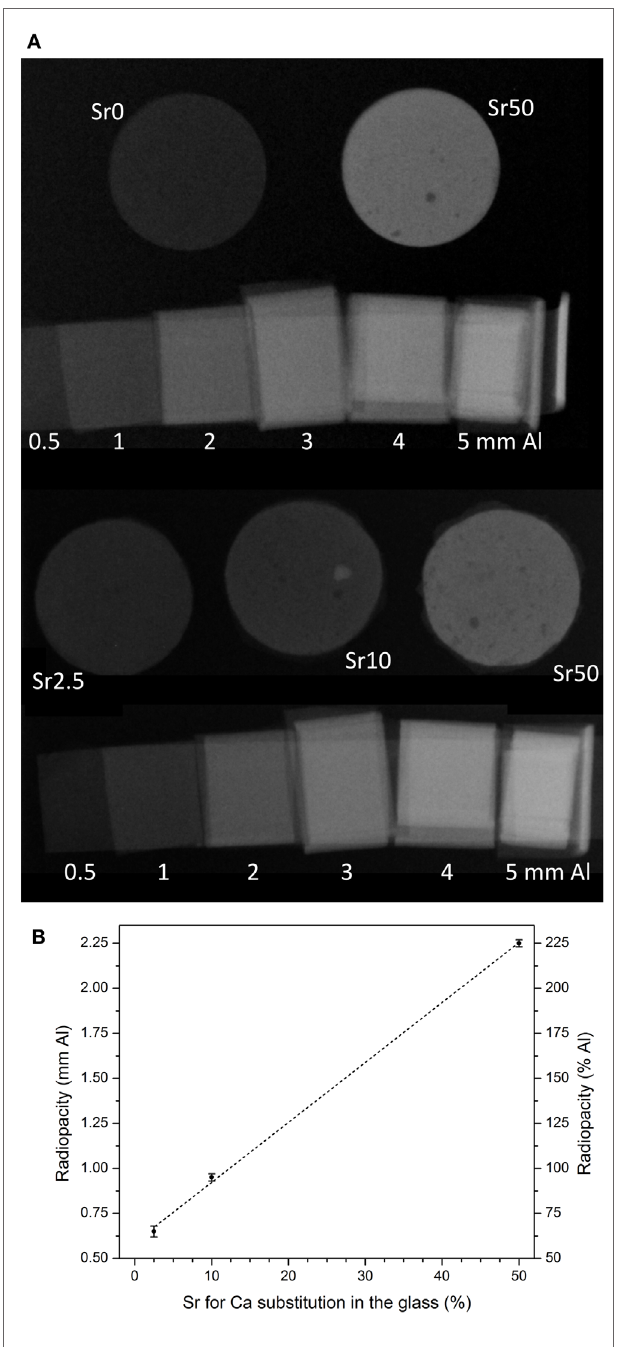
FigUre 5 | (a) Radiographic images of cement disks and aluminum step wedge and (B) radiopacity of cement disks (1 mm in height) vs. strontium for calcium substitution in the glass. Dashed line is linear regression ( R 2 =